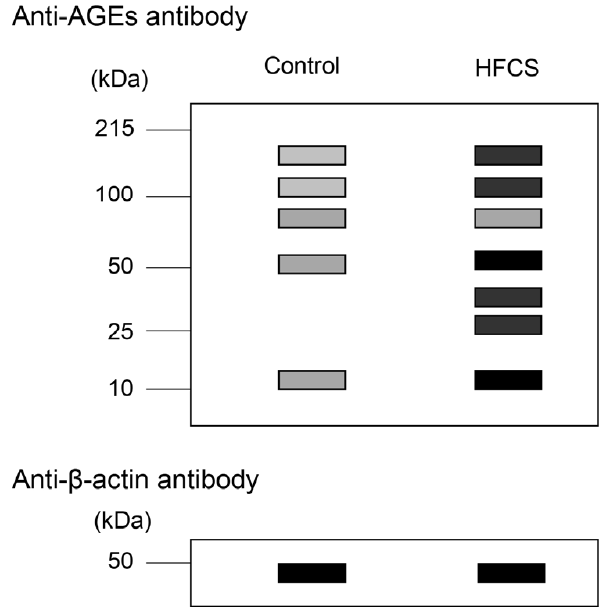
Figure 4. Model image of western blot with anti-AGE antibody and anti- β -actin. Equal amounts of lysates of hepatic tissues were used. Control: hepatic tissues of rats that had drunk water. HFCS: hepatic tissues of rats that had drunk high-fructose corn syrup (HFCS). Closed gray and black squares indicate the bands on the membrane. The luminance of each band was analyzed and normalized with β -actin. Finally, luminance amounts were quanti fi ed.